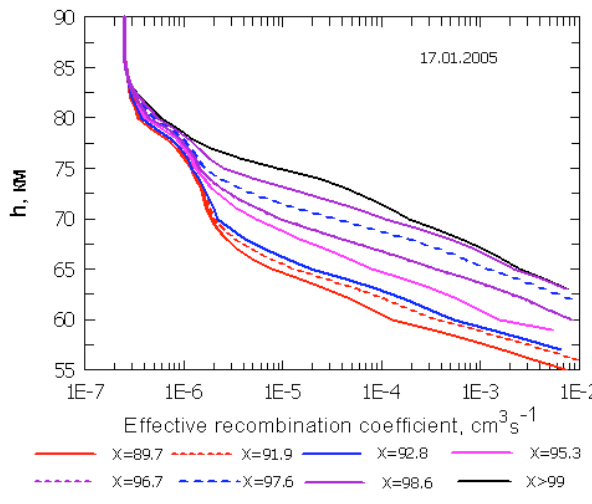
Fig. 11a. Electron density profiles measured (red solid curve and symbols) and calculated for the SPE on 17 January 2005 at 14:15UT for zenith angles 97.6 ◦ and 102.8 ◦ using the O, O 3 and NO profiles 4–6 in Fig. 1 (black curve).